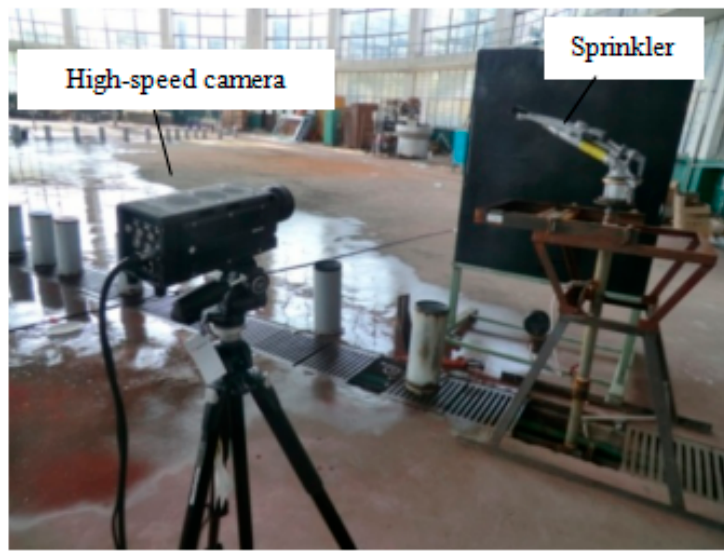
Figure 2. General view of the experimental setup.